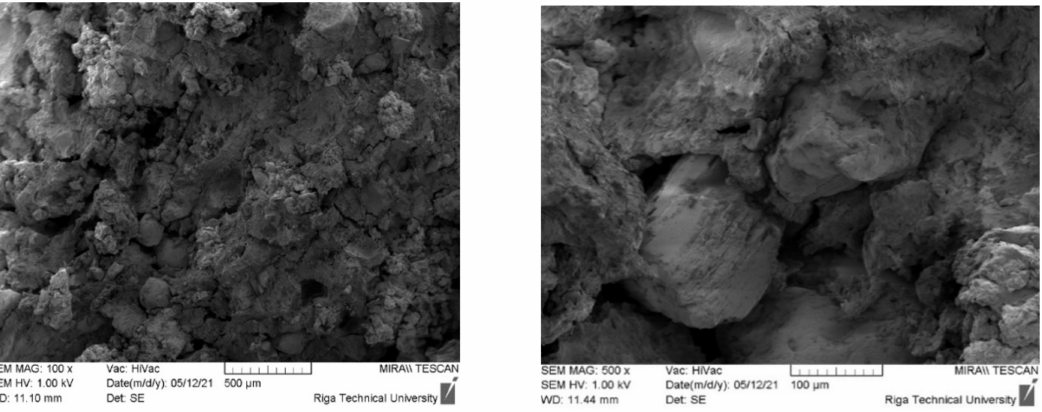
Figure 2. Sample images of samples 5-95-0 after loading taken at × 100 and × 500 magnification. The yellow arrows indicate CR